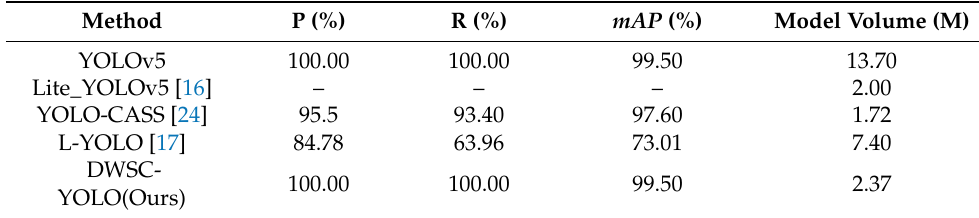
Table 2. The performance of different